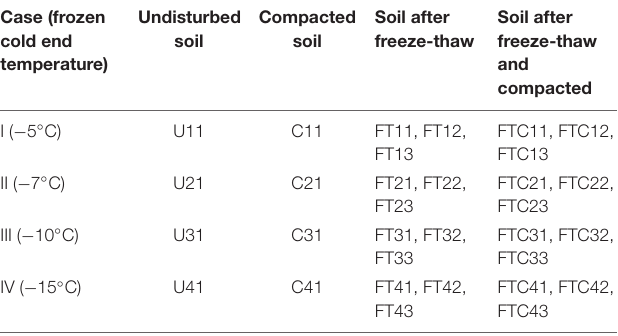
TABLE 2 | Mercury intrusion test scenarios and test plan.